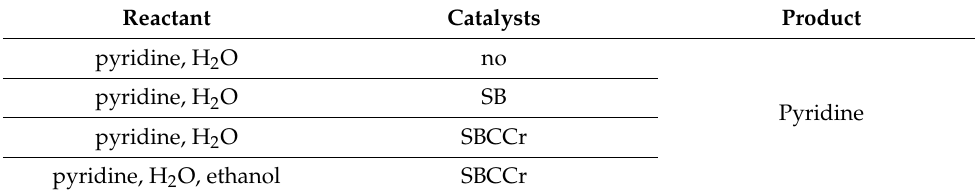
Table 10. New compounds of pyridine under different reaction conditions.